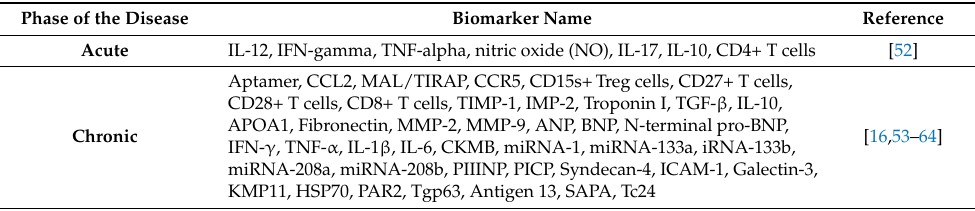
Table 2. Biomarkers used for the detection of Chagas disease by the phase of the disease.